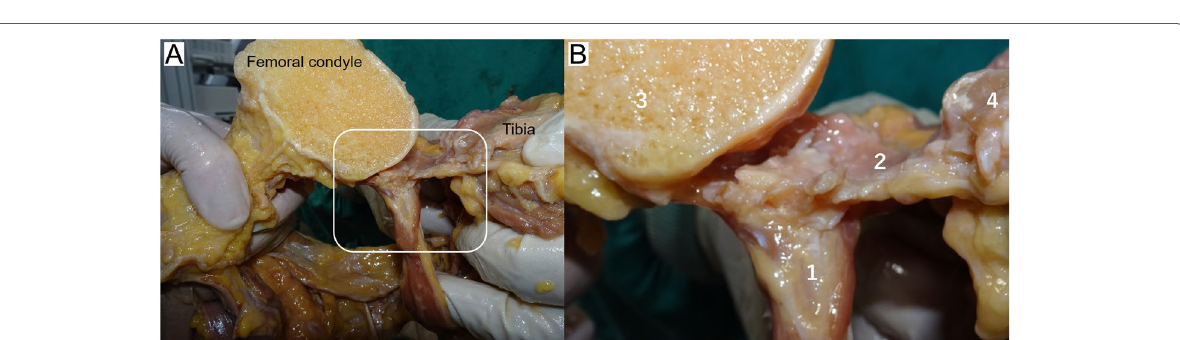
Fig. 6 The attachment form of the posterior capsule of a knee joint to the femoral cortex. A Cross-section of the medial condyle of a femur. The white square shows the attachment site of the gastrocnemius tendon and the posterior capsule to the femoral cortex. The gastrocnemius tendon and posterior capsule were attached integrally to the femoral cortex at the medial condyle; B An enlarged view of the attachment site. 1: medial head of the gastrocnemius tendon; 2: posterior capsule of a knee joint; 3: femoral condyle; 4: